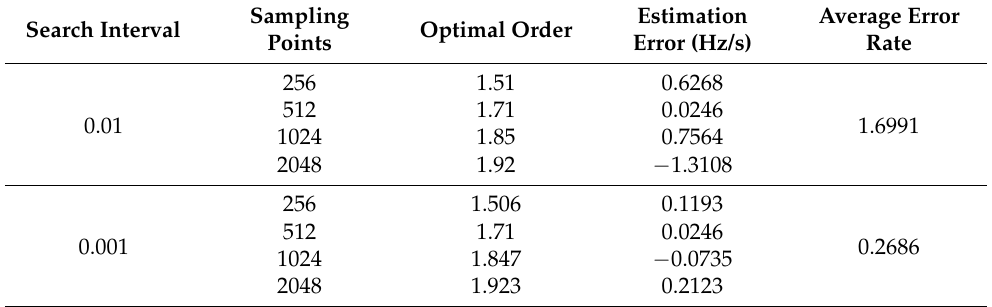
Table 1. Performance of the chirp parameter estimation under different sampling points and search intervals. Estimation Average Error Sampling Optimal Order Search Interval Error (Hz/s) Rate Points 256 1.51 0.6268 1.6991512 1.71 0.0246 0.01 1024 1.85 0.7564 2048 1.92 − 1.3108 256 1.506 0.1193 0.2686512 1.71 0.0246 0.001 1024